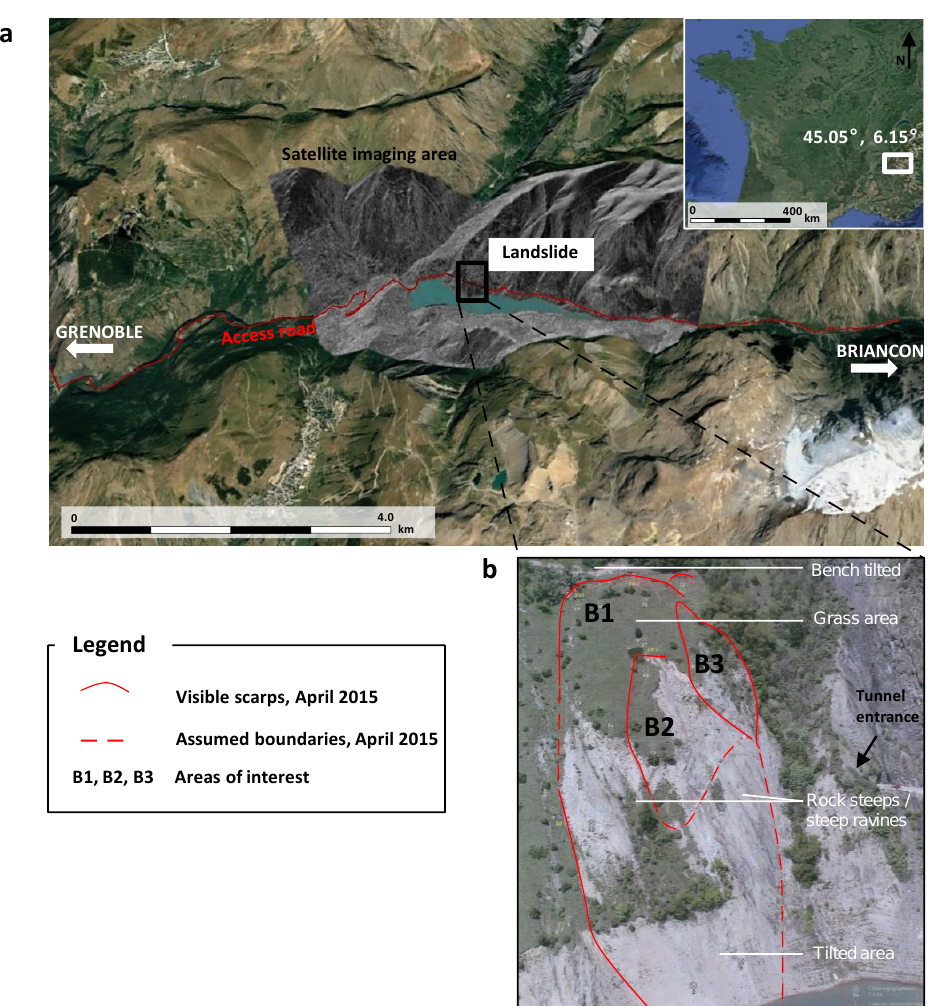
Figure 1. Landslide of the Tunnel du Chambon. ( a ) Area of study with its situation in France (source: Google Earth). The rectangular is the localization of the landslide. Shaded relief indicates the satellite imaging area used in this study. ( b ) Photography of the landslide